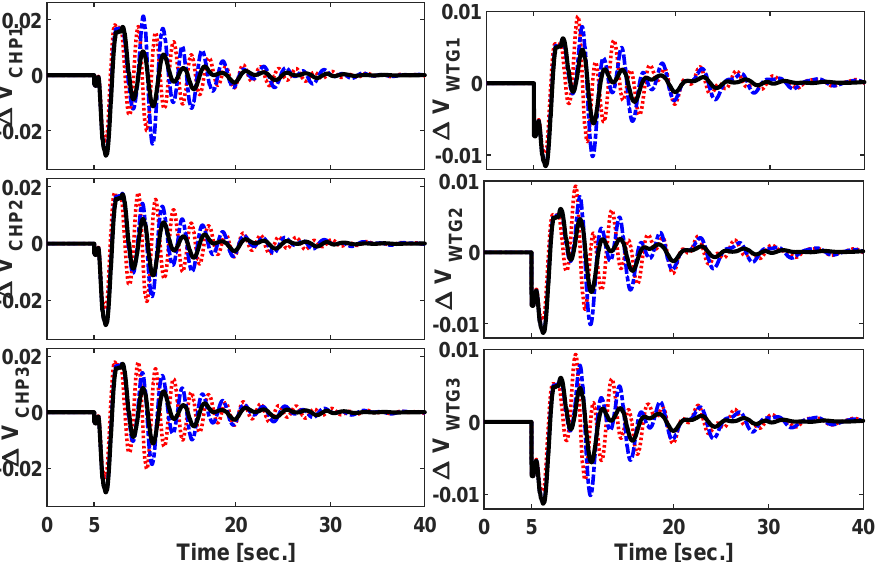
Figure 19. The oscillations of voltage at the generator buses in scenario 2; black(solid): RL-PID, blue (dashed–dotted): F-PID, red (dotted):